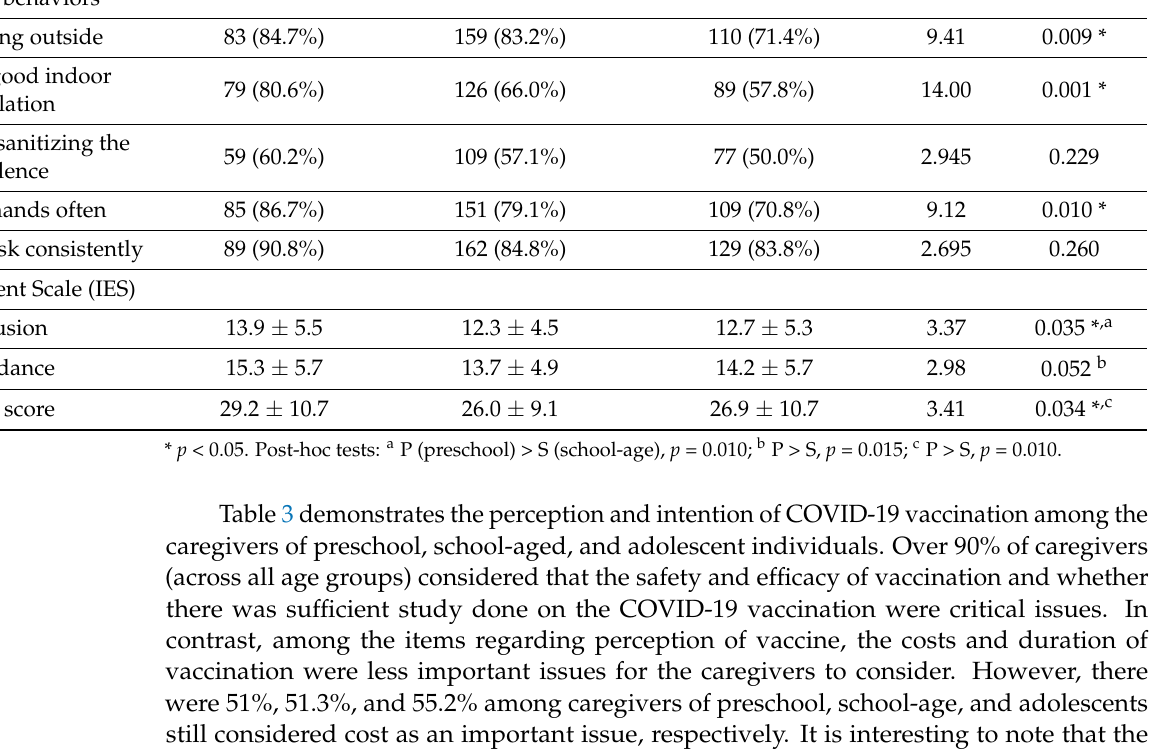
Table 2. The perception, behavioral change and influence of COVID-19 pandemic among the care-